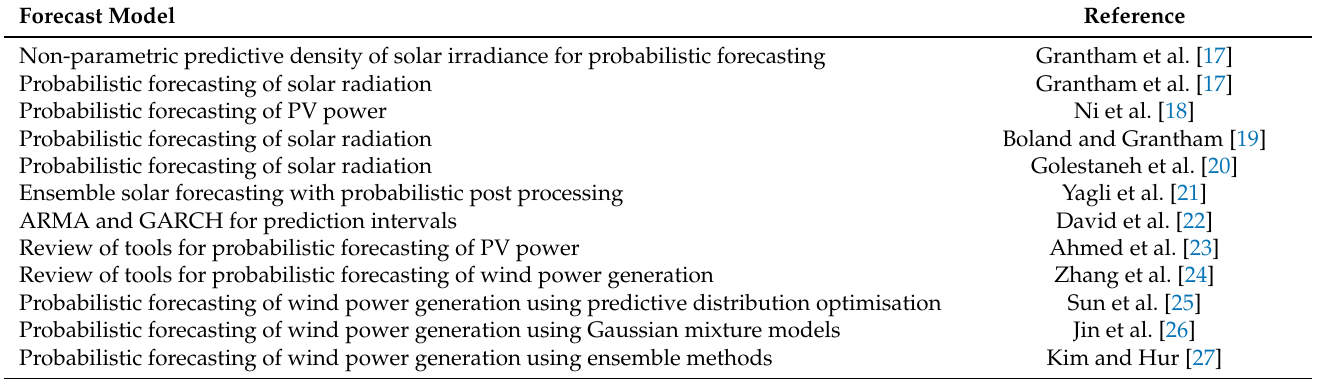
Table 2. Interval